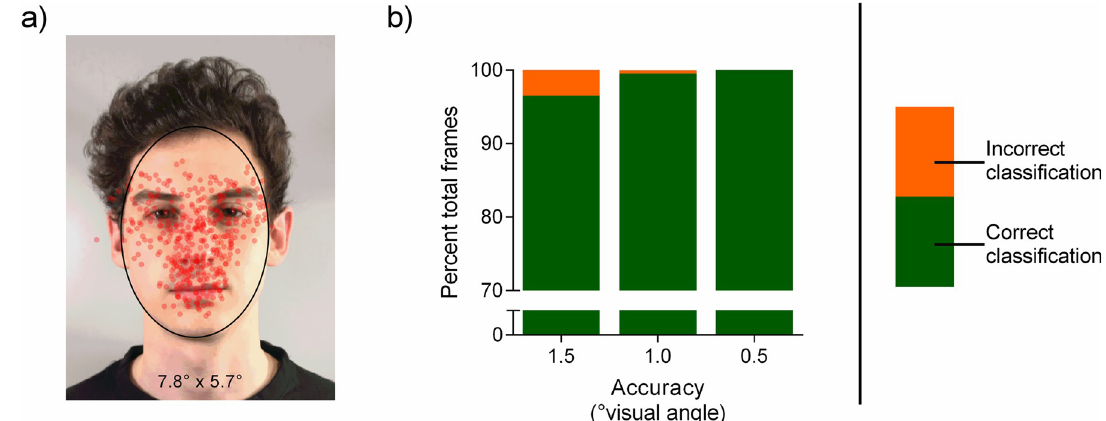
Fig 4. Effect of gaze data accuracy on classification performance of simulated fixations (on eyes, nose & mouth) within the face ellipse. (A) Visualization of the face ellipse and the simulated fixation points with an accuracy of 1.5˚ (n = 100, averaged over 30 simulated fixations) in red. (B) Green indicates correct classification within the face ellipse compared to orange for misclassification outside the face ellipse. The stimulus shown in A was created for illustrative purposes only and is not part of the stimulus set used in the study (see Methods